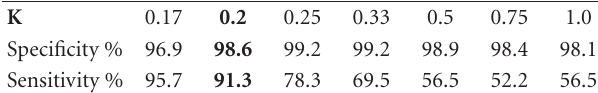
Table 1: Detection results using self-learning